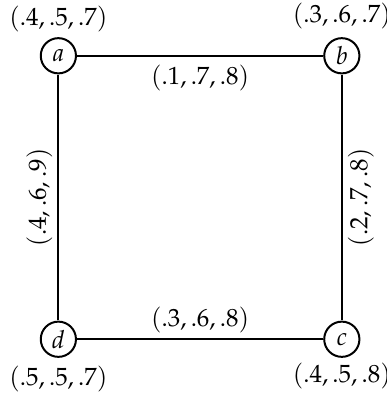
Figure 5. m -highly irregular neutrosophic